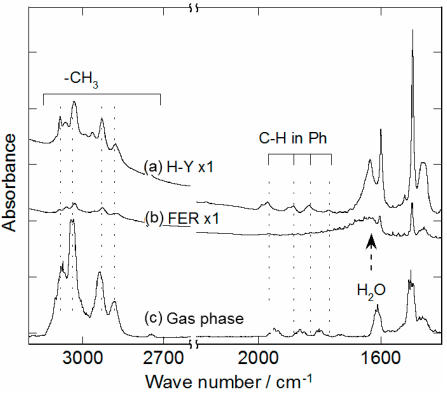
Figure 6. Infrared spectra for toluene ( a ) on H-Y(1) zeolite, ( b ) on FER, and ( c ) in the gas